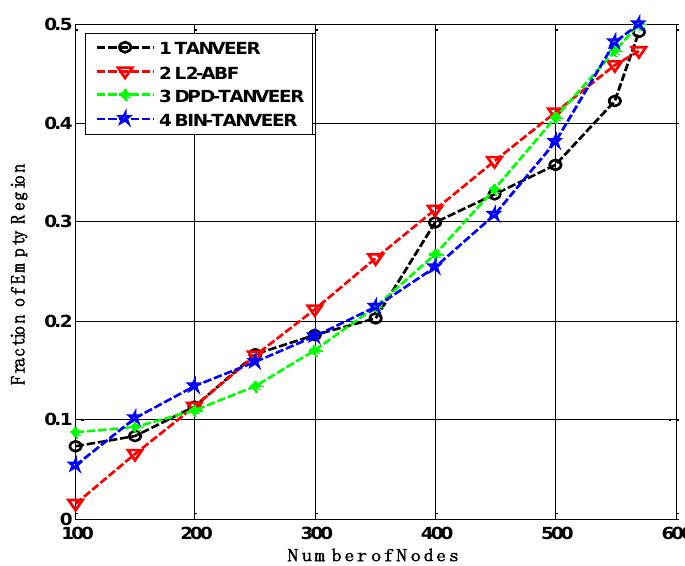
Figure 12. Fraction of empty regions occurrence in TANVEER vs L2-ABF.